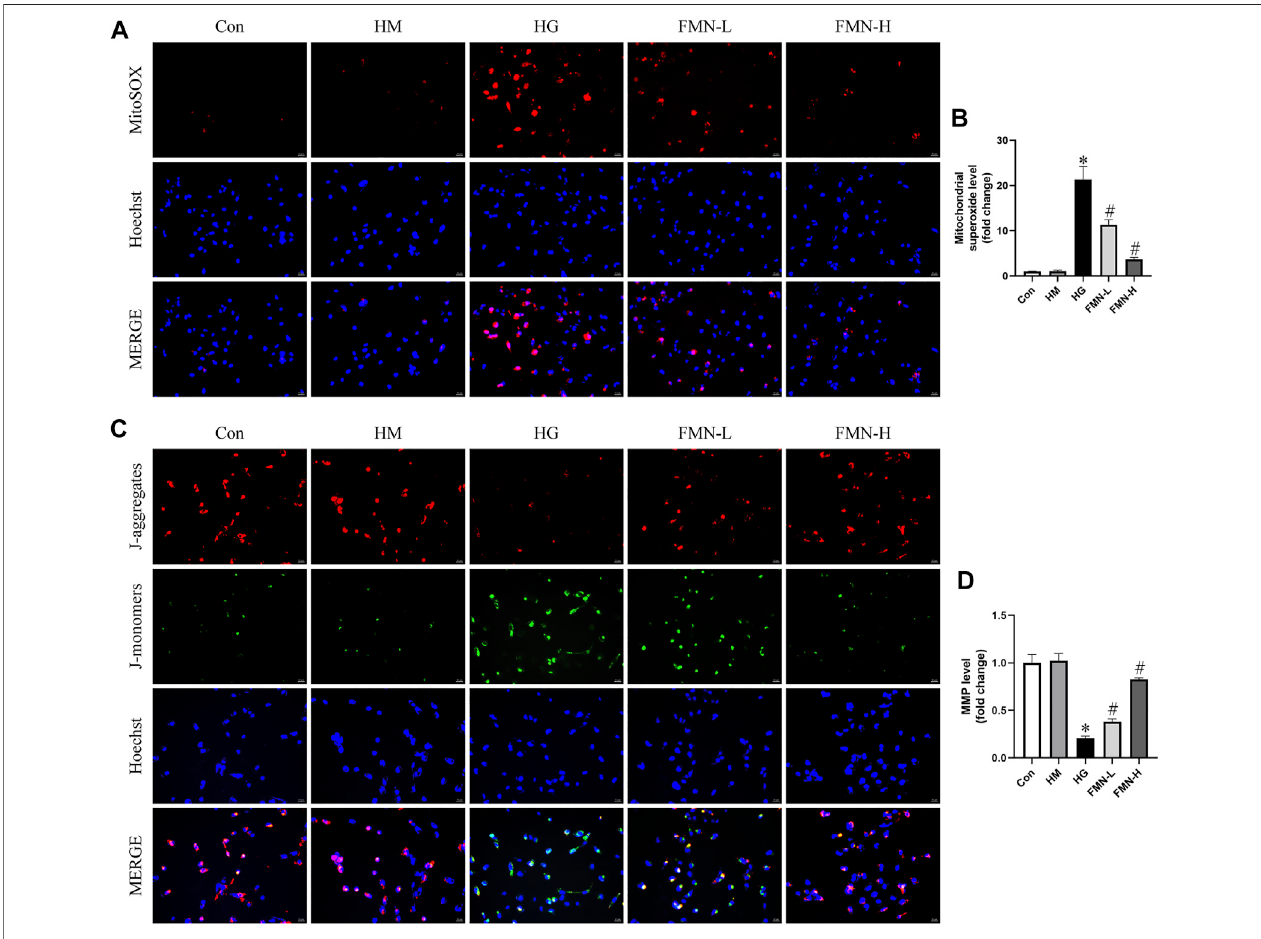
FIGURE 7 | FMN reduced mitochondrial superoxide overproduction and restored MMP levels. (A,B) Representative images and semiquantitative analysis of mitochondrialsuperoxideproductioninHK-2cells(originalmagni fi cation×200,bars=50 µm). (C,D) RepresentativeimagesandsemiquantitativeanalysisofMMPlevels in HK-2 cells (original magni fi cation ×200, bars = 50 µm). Results were expressed as mean ± SD. * p < 0.05 vs. control group. # p < 0.05 vs. HG